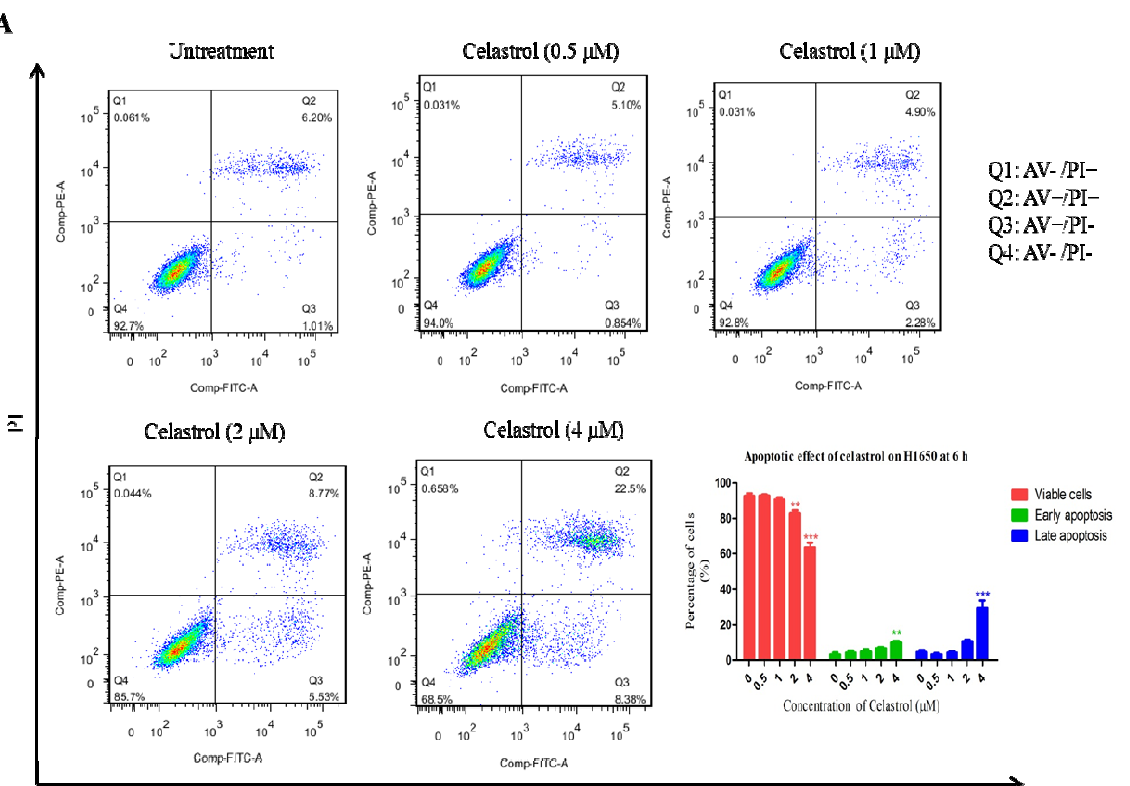
Figure 2. Celastrol induced apoptosis in H1650 cells at different time points. ( A ) After treating with celastrol (0.5, 1, 2, 4 μ M) for 6 h, cells were collected for apoptosis analysis. ( B ) Cells were collected for apoptosis analysis at 24 h after the treatment of celastrol (0.5, 1, 2, 4 μ